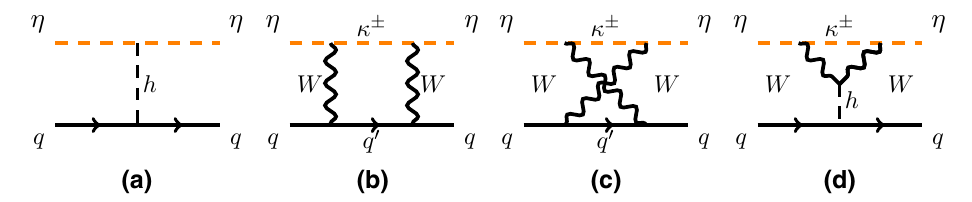
Fig. 2 a Tree level contribution to the cross section for spin-independent scattering of DM on nucleons. b – d Representative examples of loop- induced diagrams which are relevant for the m (cid:7) -independent piece of the cross section